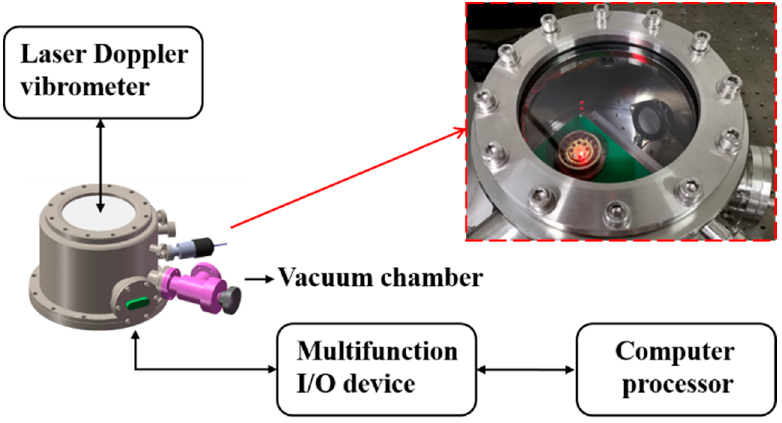
Figure 3. The diagram of the experimental setup used for the testing of both the VCMs and the VCPs.